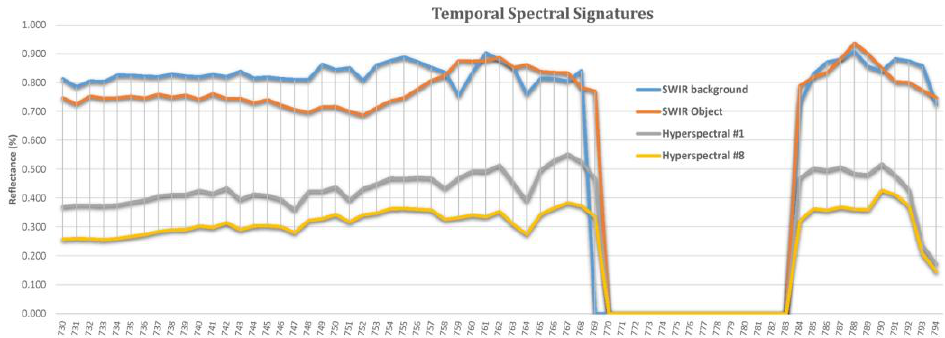
Figure 5: The temporal spectral signatures of both the targets as well as the background are calculated and employed during